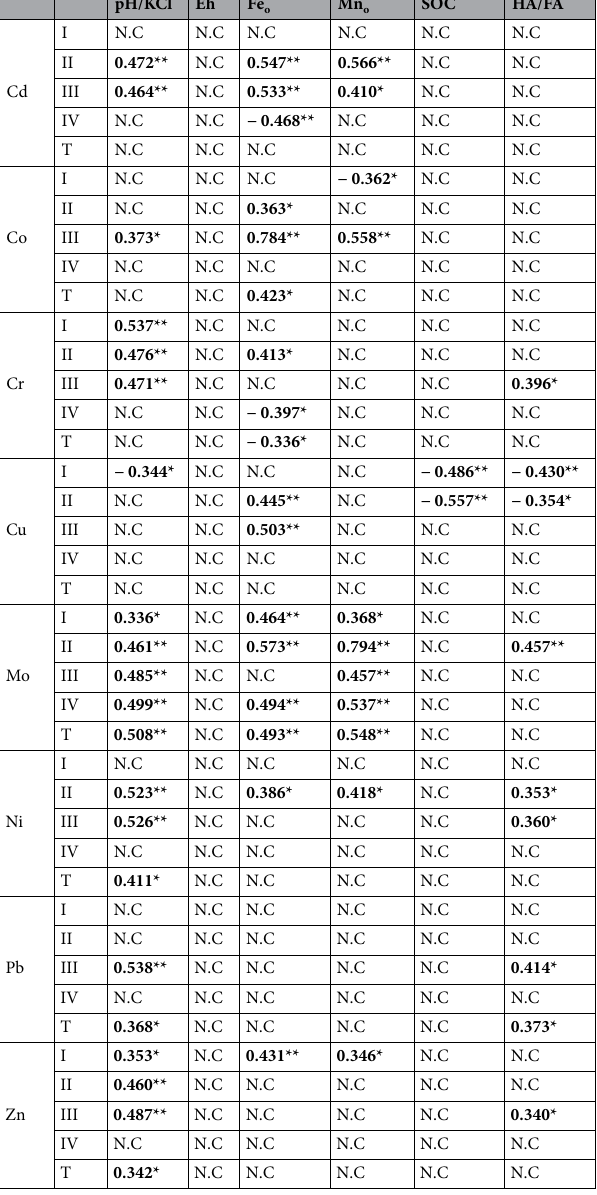
Table 5. Pearson’s correlation coefficient matrix of HMs in various fractions and soil chemical properties. I exchangeable fraction, II reducible fraction, III oxidisable fraction, IV residual fraction, T total content; *r values shown in bold are significant at p < 0.05; **r values shown in bold are significant at p < 0.01, N.C no